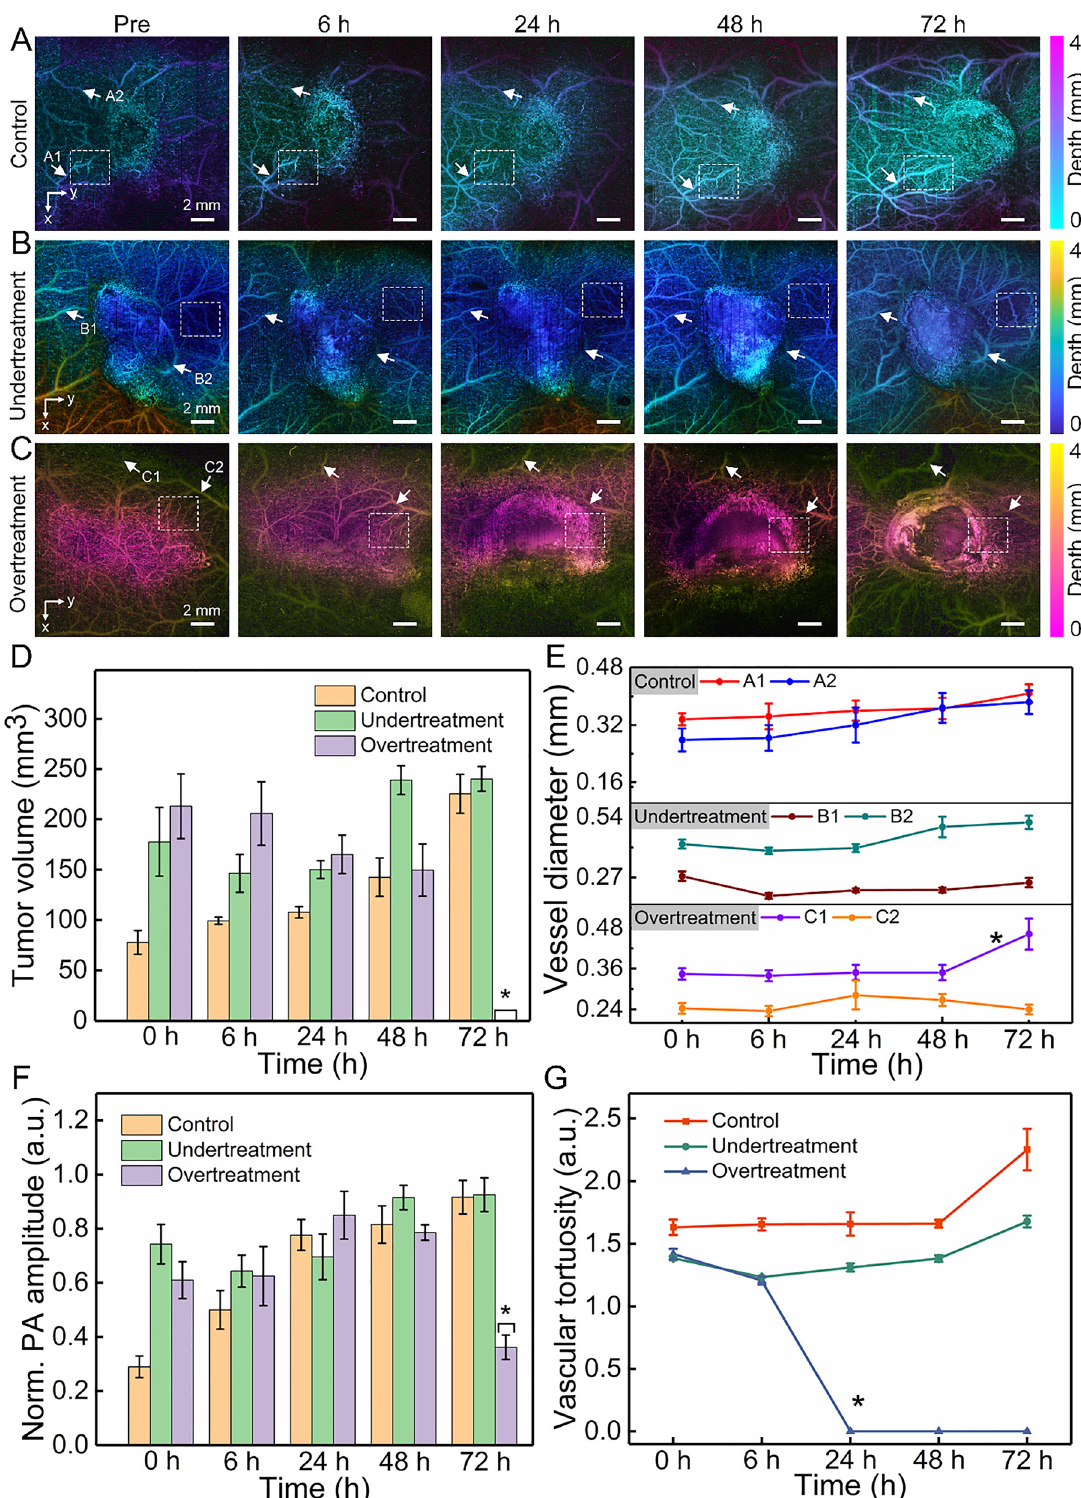
Figure 4: Monitoring of tumors undergoing different in situ photothermal treatments. (A) PA imaging results in the control group. (B) PA imaging results in the undertreatment group. (C) PA imaging results in the overtreatment group. (D) Tumor volumes in different experimental groups at different timing. (E) The diameter changes of the draining vessels in different treatment